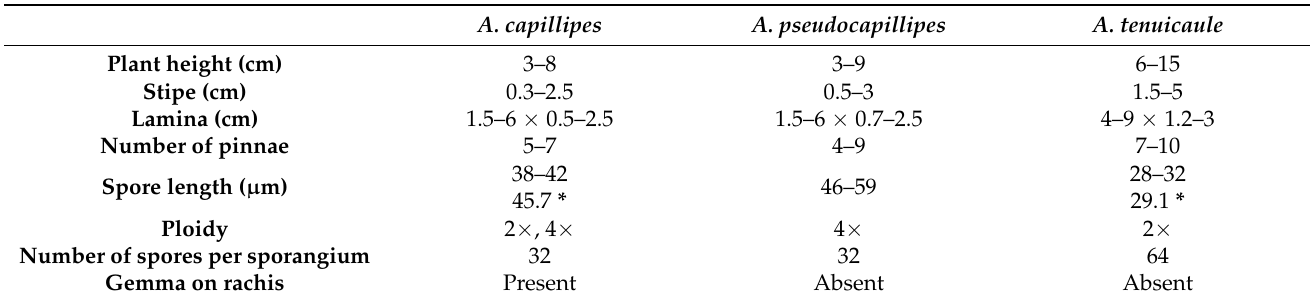
Table 1. A comparison of A. pseudocapillipes and two parental species. Measurements of A. capillipes and A. tenuicaule were referred to in the Flora of China [18]. Asterisk (*) is a measurement of the spore length according to Ichihara [24].